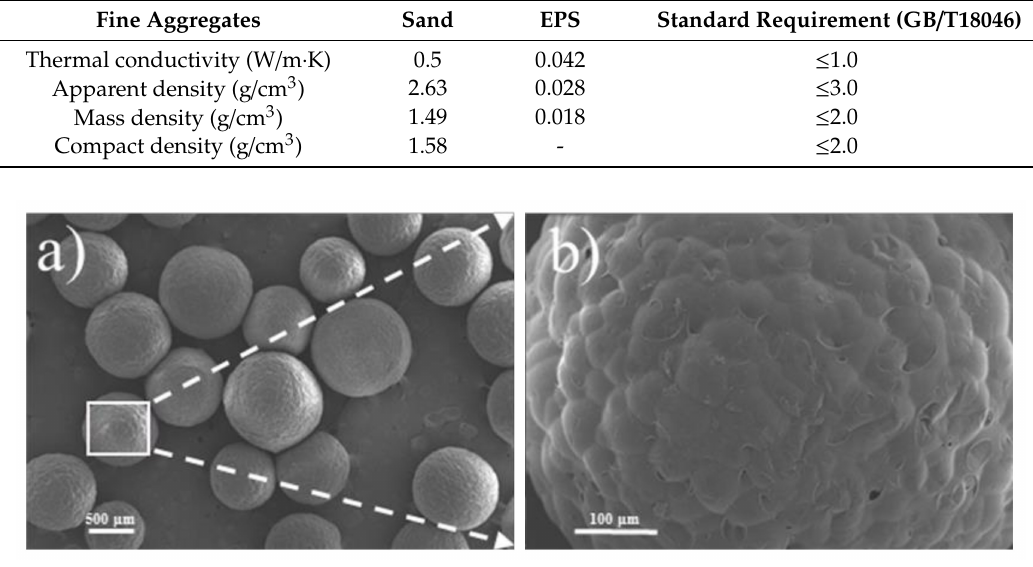
Figure 3. Microstructural morphology of waste EPS beads by SEM: ( a ) EPS at 20 × and ( b ) EPS at 150 ×